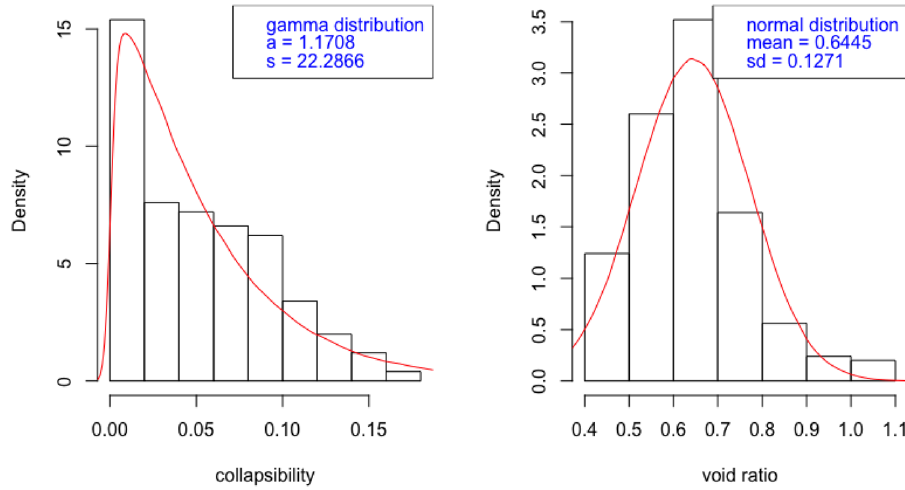
Figure 4. Probability description of collapsibility and porosity ratio: Yan’an Area.